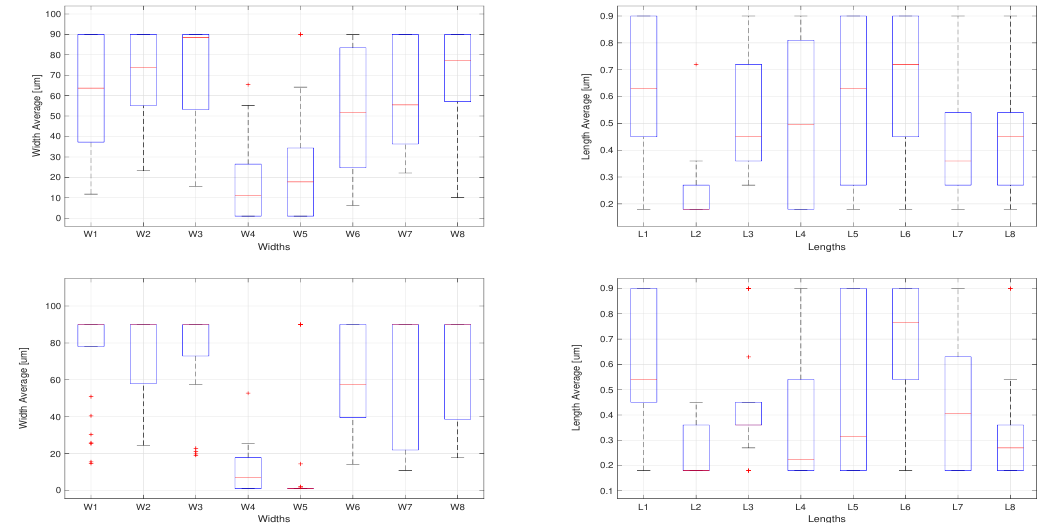
Figure 12. Box plots of the widths and lengths of the transistors of the RFC-OTA applying PSO (in the first row) and MOL (in the second